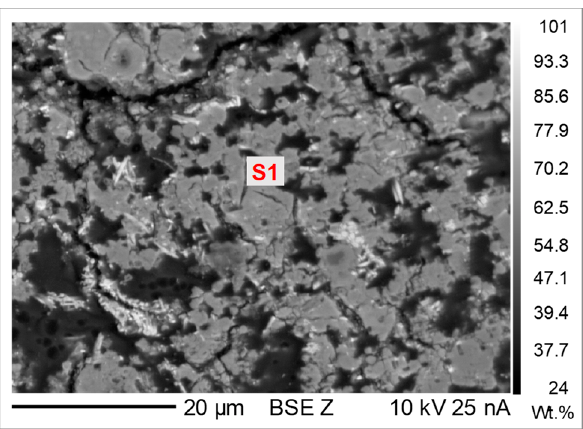
Figure 19. Backscattered electron image of the delicate flakes found in the residue.